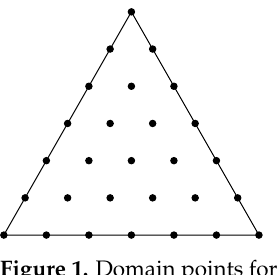
Figure 1. Domain points for d =